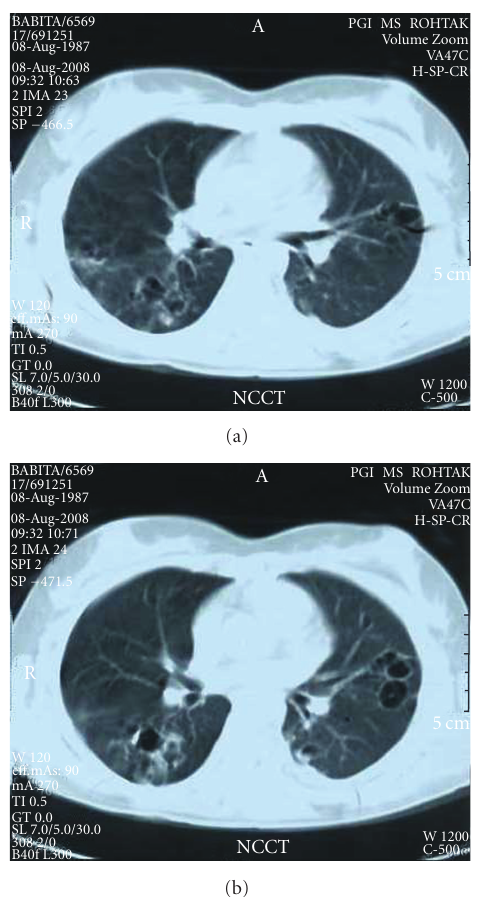
Figure 2: CT sections showing bronchiactatic patches.